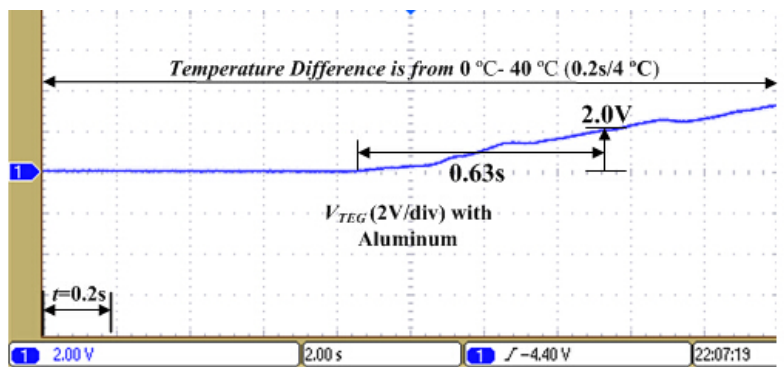
Figure 12. Measured waveform of the output voltage (Channel 1) of the TE board with aluminum attached as the thermally conductive material.